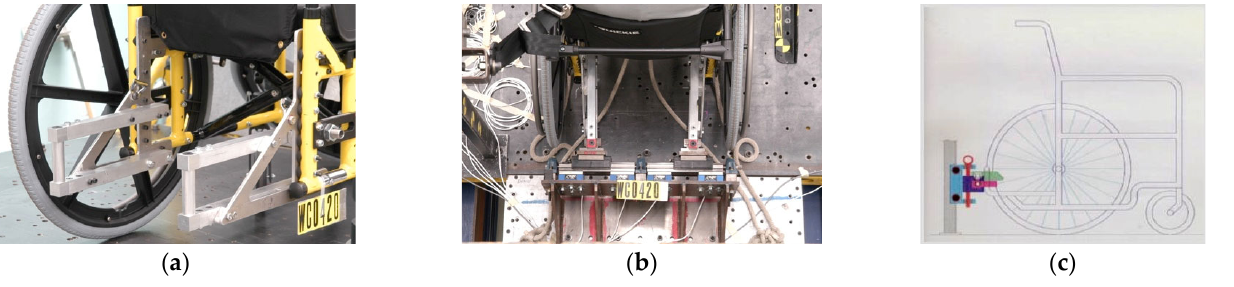
Figure 4. UDIG attachment hardware on wheelchair ( a ), a wheelchair engaged with UDIG mounting hardware ( b ), and a diagram of UDIG geometry ( c ).